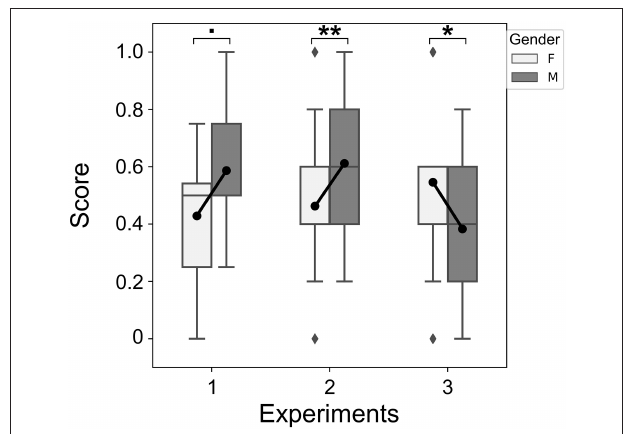
FIGURE 3 | Alignment scores in Experiments 1, 2, and 3 by gender of participants. (cid:5) 0.05 < p < 0.1; * p < 0.05; ** p < 0.01.